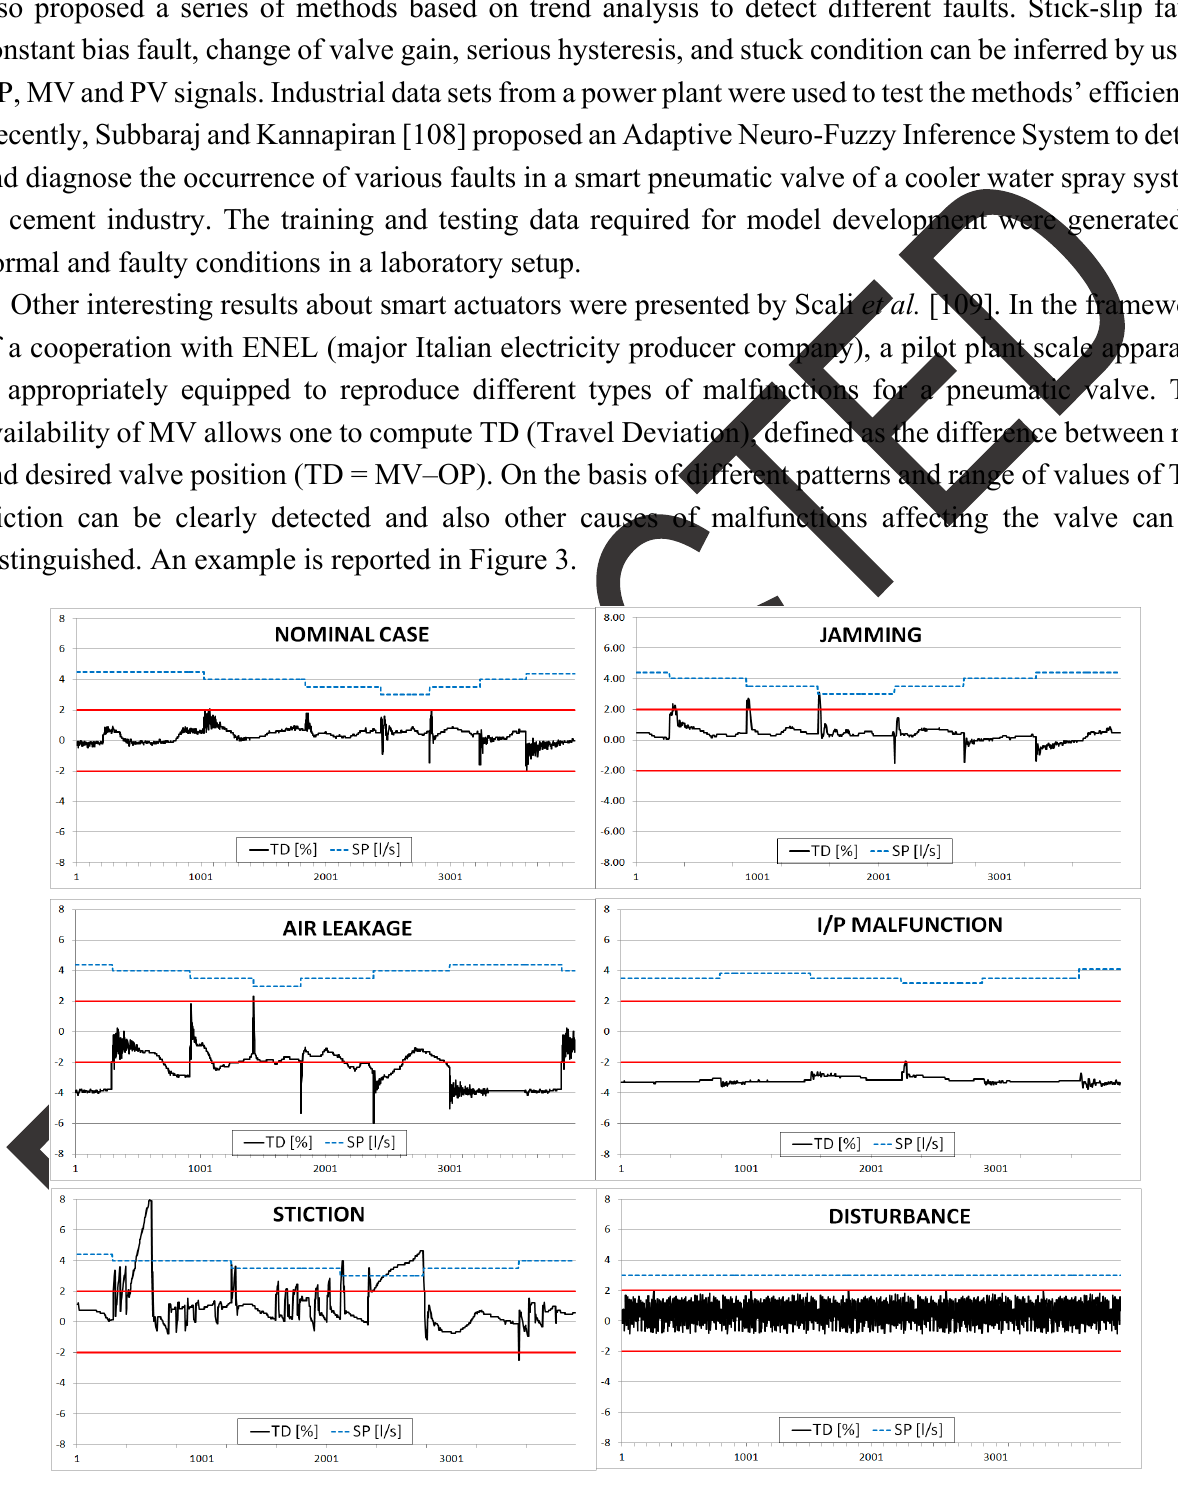
Figure 3. TD time trends for nominal case and different malfunctions: jamming, air leakage, I/P malfunction, stiction and